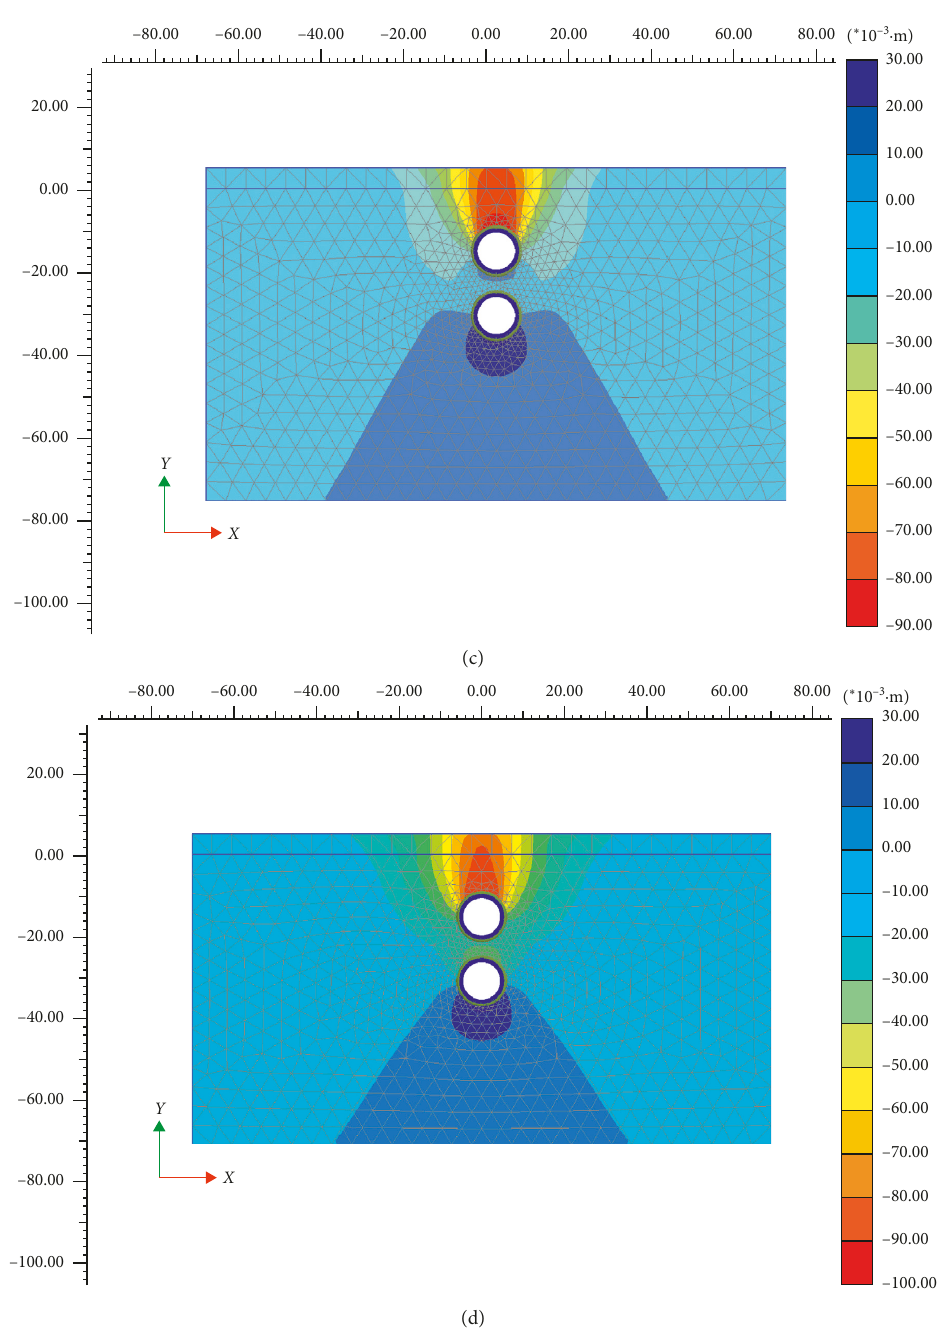
Figure 6: (a) Twin tunnels ( u � 0.55 D ) in vertical configuration (dimensions in cm). (b) Settlement trough of vertical twin tunnels ( u � 0.55 D ). (c) Displacement contours of vertical twin tunnels (top constructed first). (d) Displacement contours of vertical twin tunnels (bottom constructed